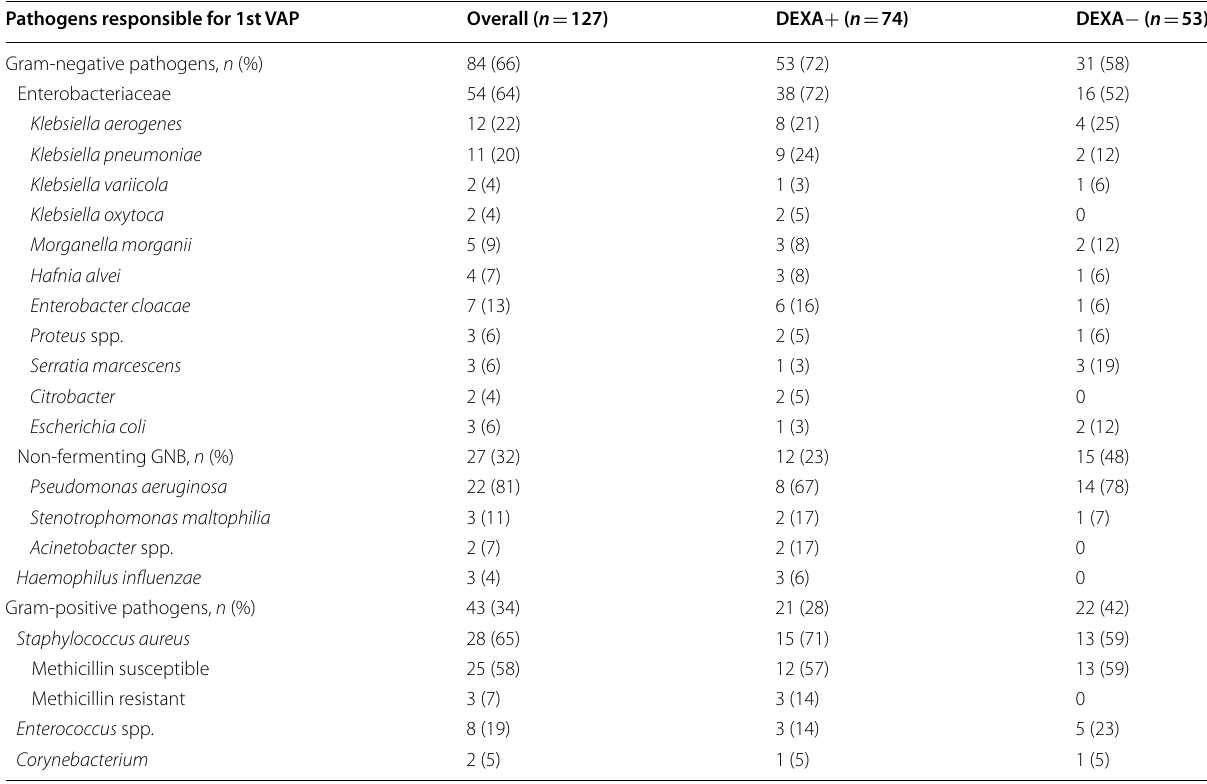
Data are presented as absolute value and